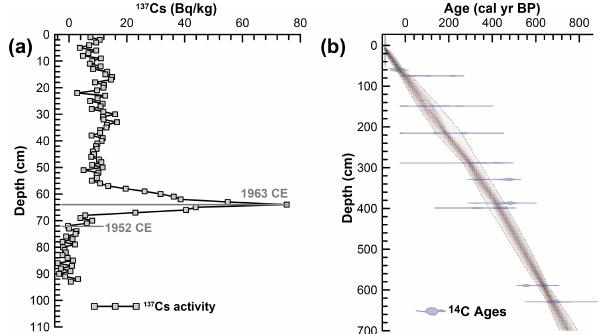
Figure 3. Age–depth model for the DLC1819 core of Lake Da- longchi. (a) The 137 Cs activity versus depth in the uppermost sed- iments. (b) Bayesian age-model for the calibrated ages. The black dotted lines indicate the 95% probability intervals of the